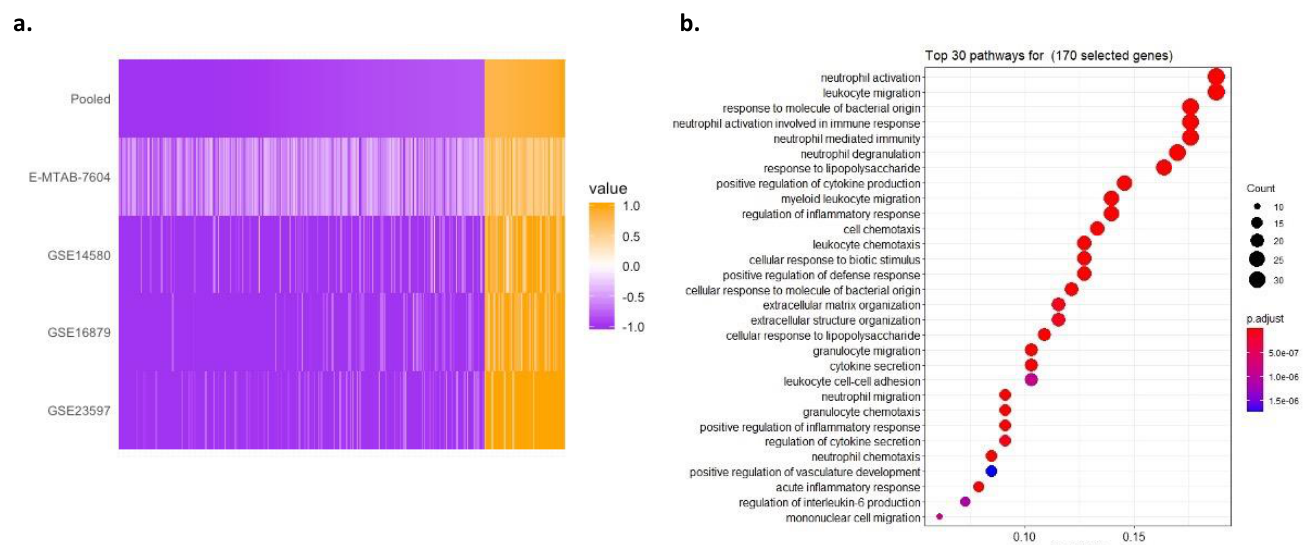
Figure 1. Multicohort analysis of IBD cohorts reveals 324 significant DE genes. ( a ) Heatmap of 324 DE genes’ effect sizes sorted by pooled summary effect size. Genes were selected by |pooled summary effect size| > 0.8, FDR < 10% in a LOSO multicohort analysis between anti-TNF α responders vs. non-responders in 4 individual datasets. ( b ) Thirty top-ranked significantly enriched GO terms revealed by the gene-set enrichment of the 324 GE genes. GeneRatio in x -axis represents the number of genes in our gene set within a pathway (size of points) out of the total number of genes of that pathway. The adjusted p -value of enrichment of our gene set in each pathway is shown by the color of points.